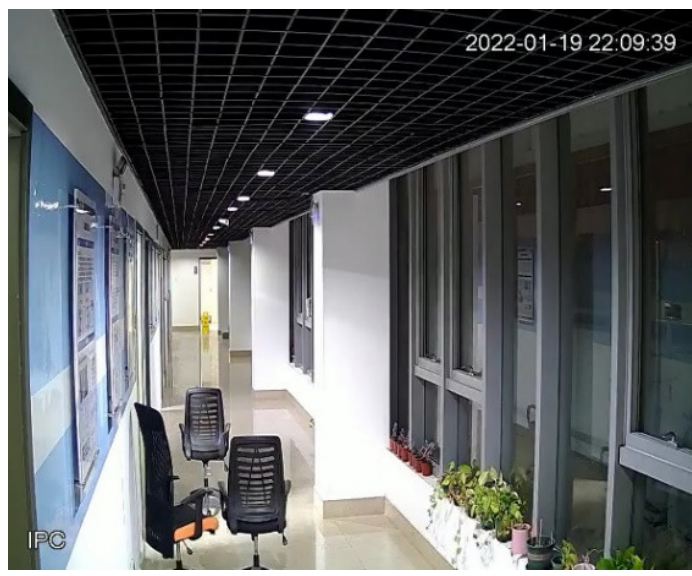
Figure 13. Experimental scenario with three obstacles.